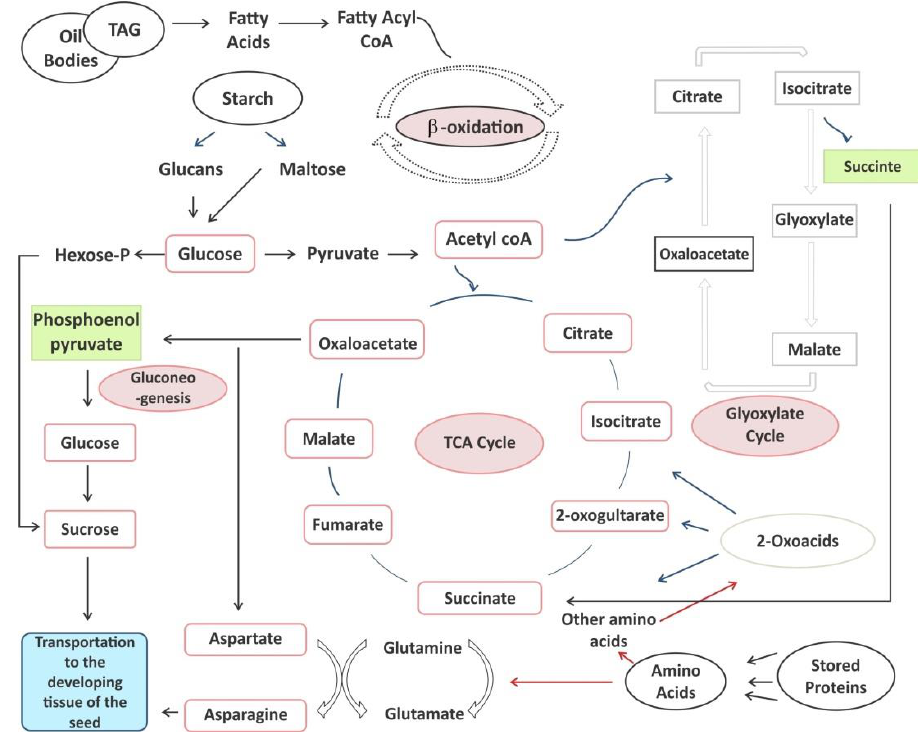
Figure 3. Interlinking of the carbon (sugars and lipids) and nitrogen (amino acids) cycles during seed germination.